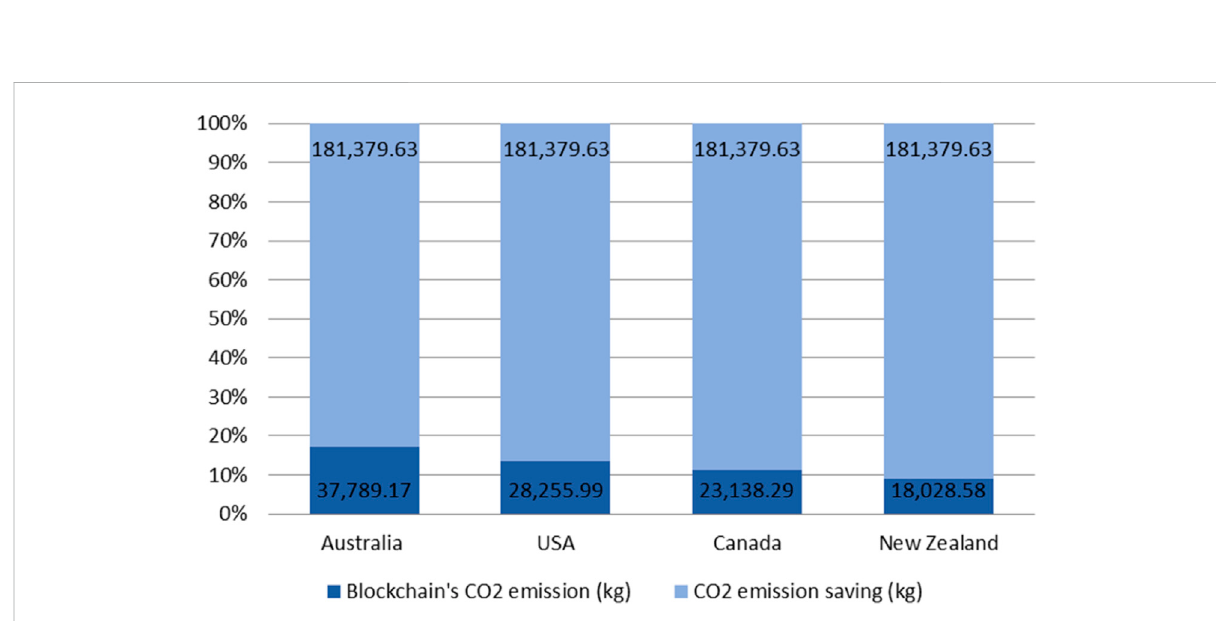
FIGURE 4 Blockchain ’ s and households ’ energy consumption in different